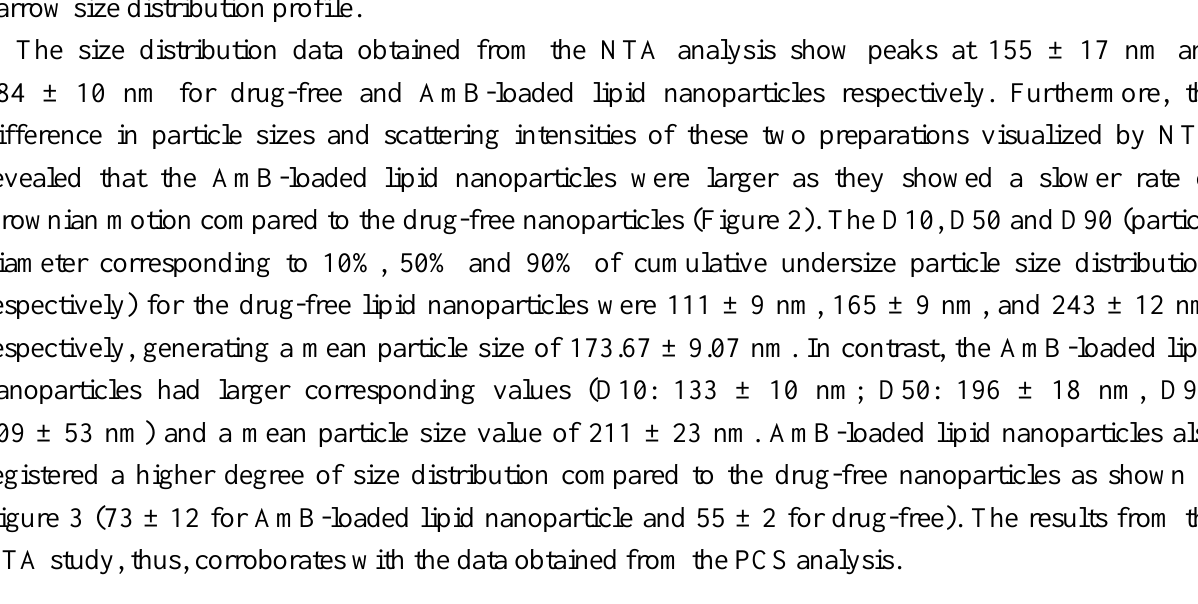
Figure 2. NTA static video images of ( a ) drug-free; ( b ) AmB-loaded solid lipid